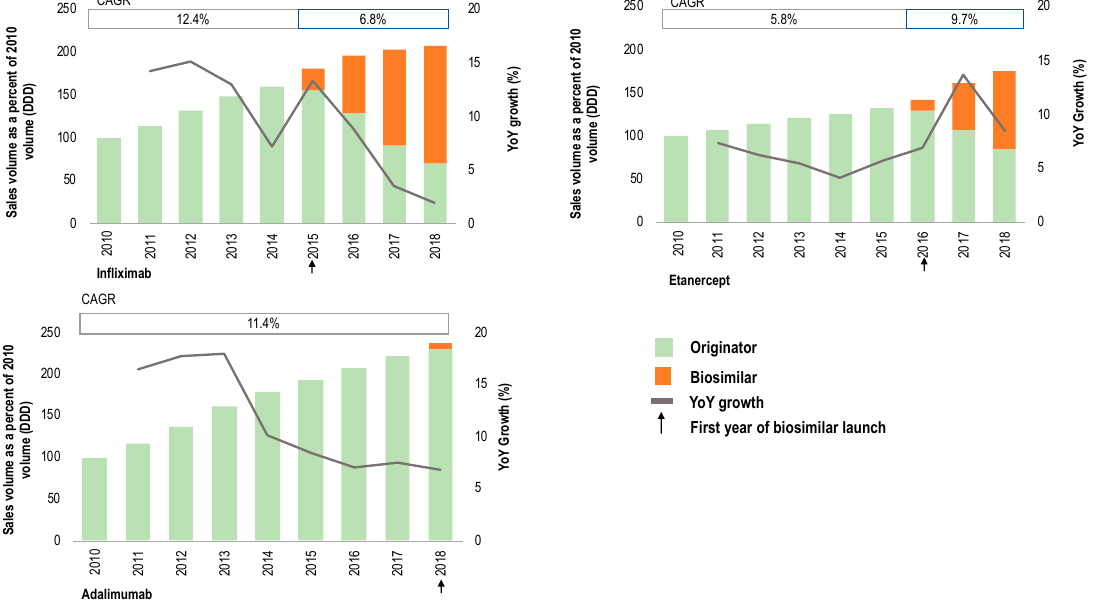
Figure 1. Sales volume evolution (2010–2018) expressed as a percentage of 2010 volume and measured as defined daily doses (DDDs) for originator and biosimilar products containing infliximab, etanercept and adalimumab (primary axis). Year-over-year (YoY) growth (%) is represented on the secondary axis. Compound annual growth rate (CAGR) is calculated before and after biosimilar launch. The graphical representation of the data is based on a figure published by IQVIA [26].